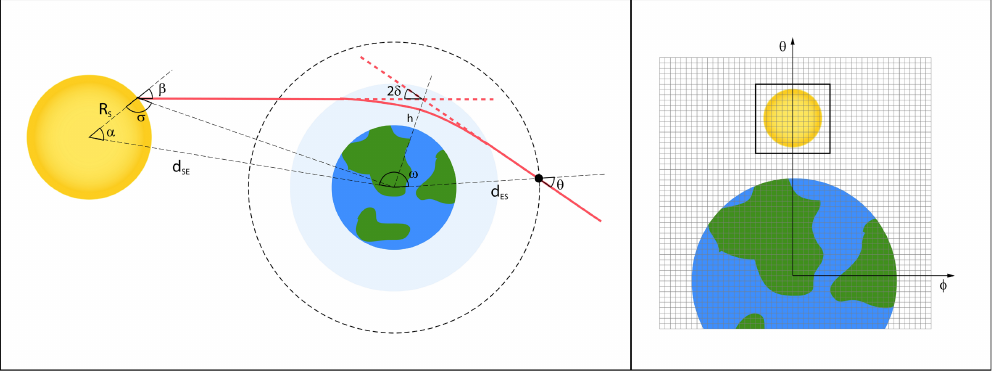
Fig. 1. Left panel: illustration of the 1-D ray tracing problem for photon trajectories in the Sun–Earth–spacecraft plane. Right panel: illus- tration of the reference frame for vertical and horizontal viewing directions as seen from the instrument. The origin of the coordinate system is at the intersection of the axes and the black box illustrates a possible instrument field of view. Relative sizes of the Earth, the Sun and the pixels are not representative of the orbit and instrument parameters used in this